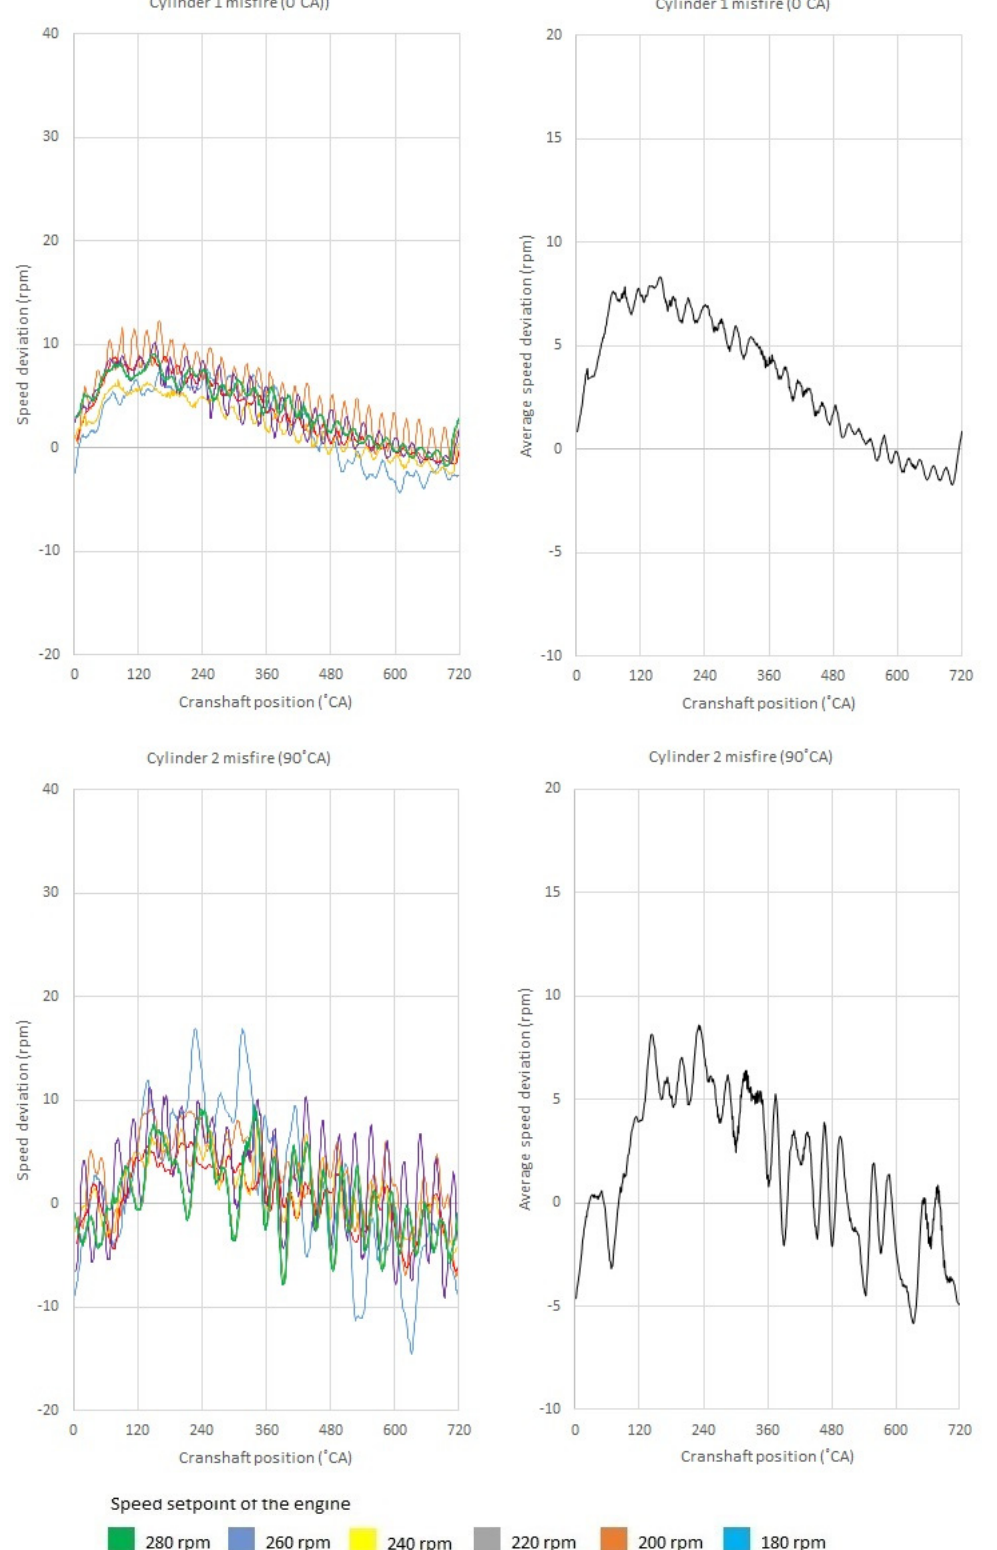
Figure 15. Instantaneous speed differences and the average deviation of the combustion loss in cylinders 1 and 2 of a Buckau-Wolf R8DV-136 engine.